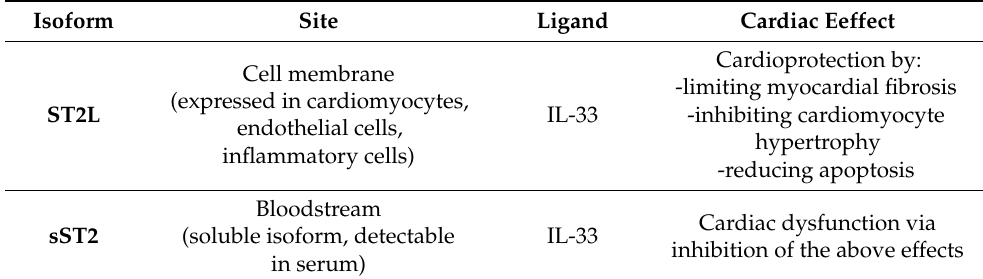
Table 1. ST2: two isoforms with opposite cardiovascular